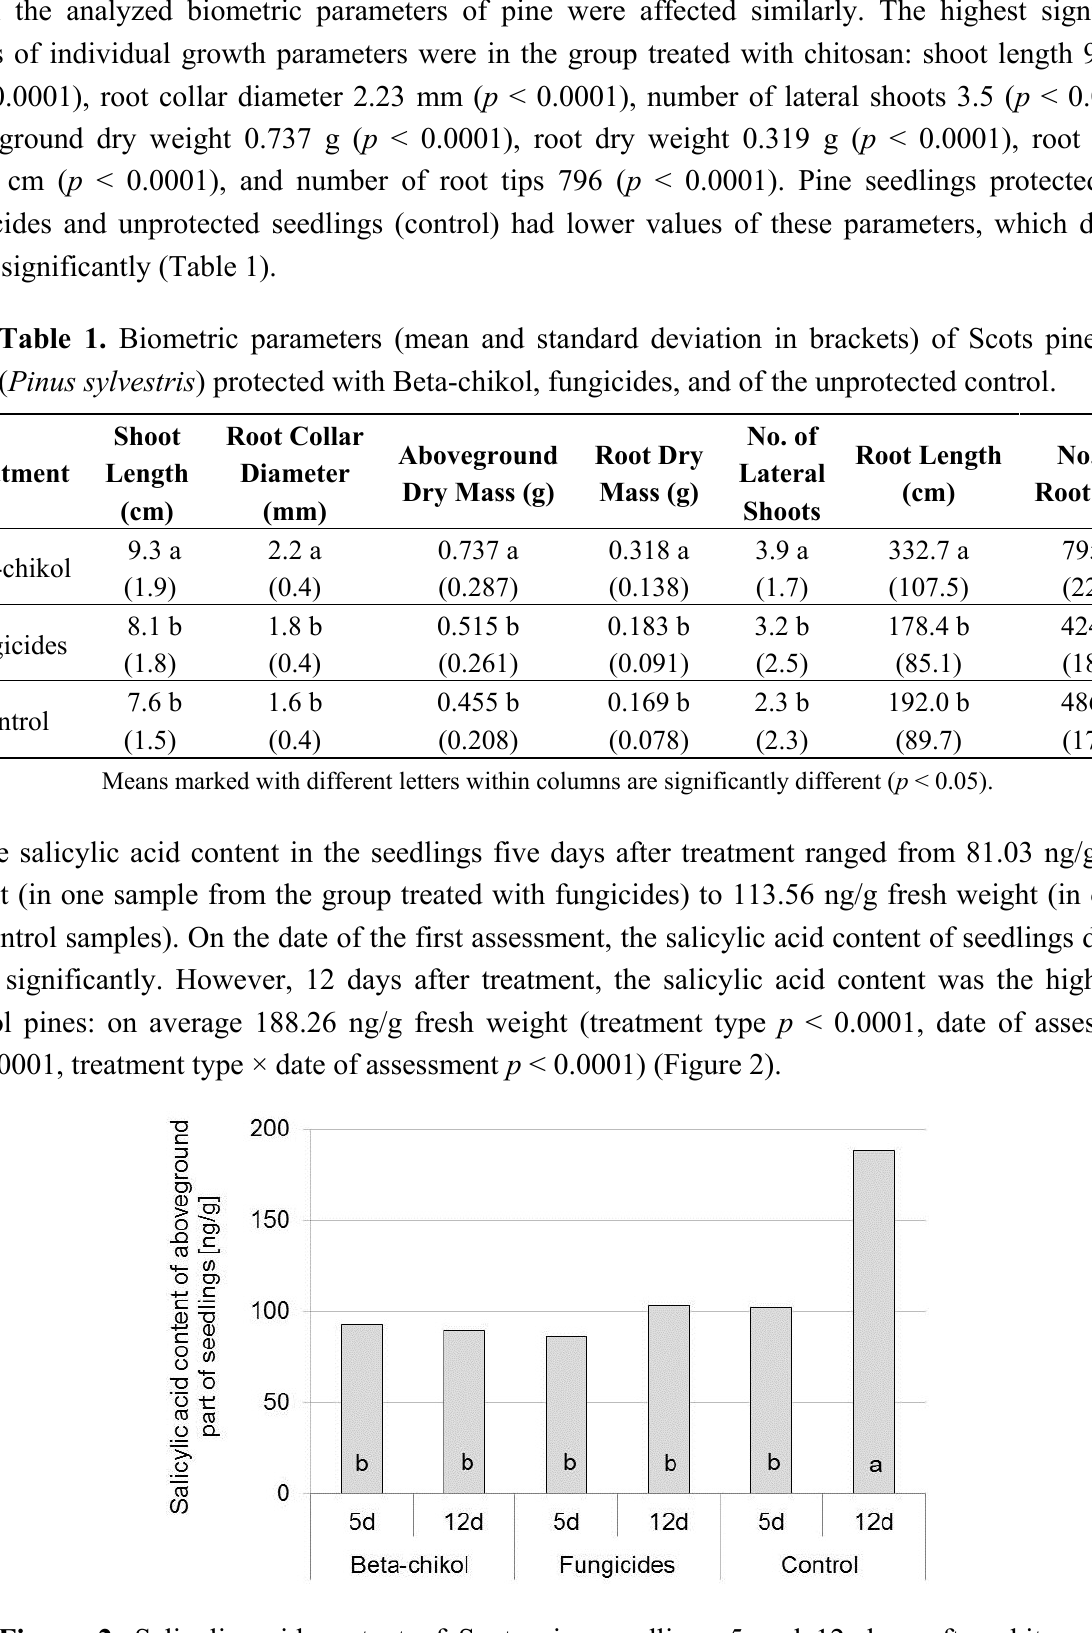
Figure 2. Salicylic acid content of Scots pine seedlings 5 and 12 days after chitosan treatment in variants with Beta-chikol, fungicides, and no protection (control). Explanations are as in Figure